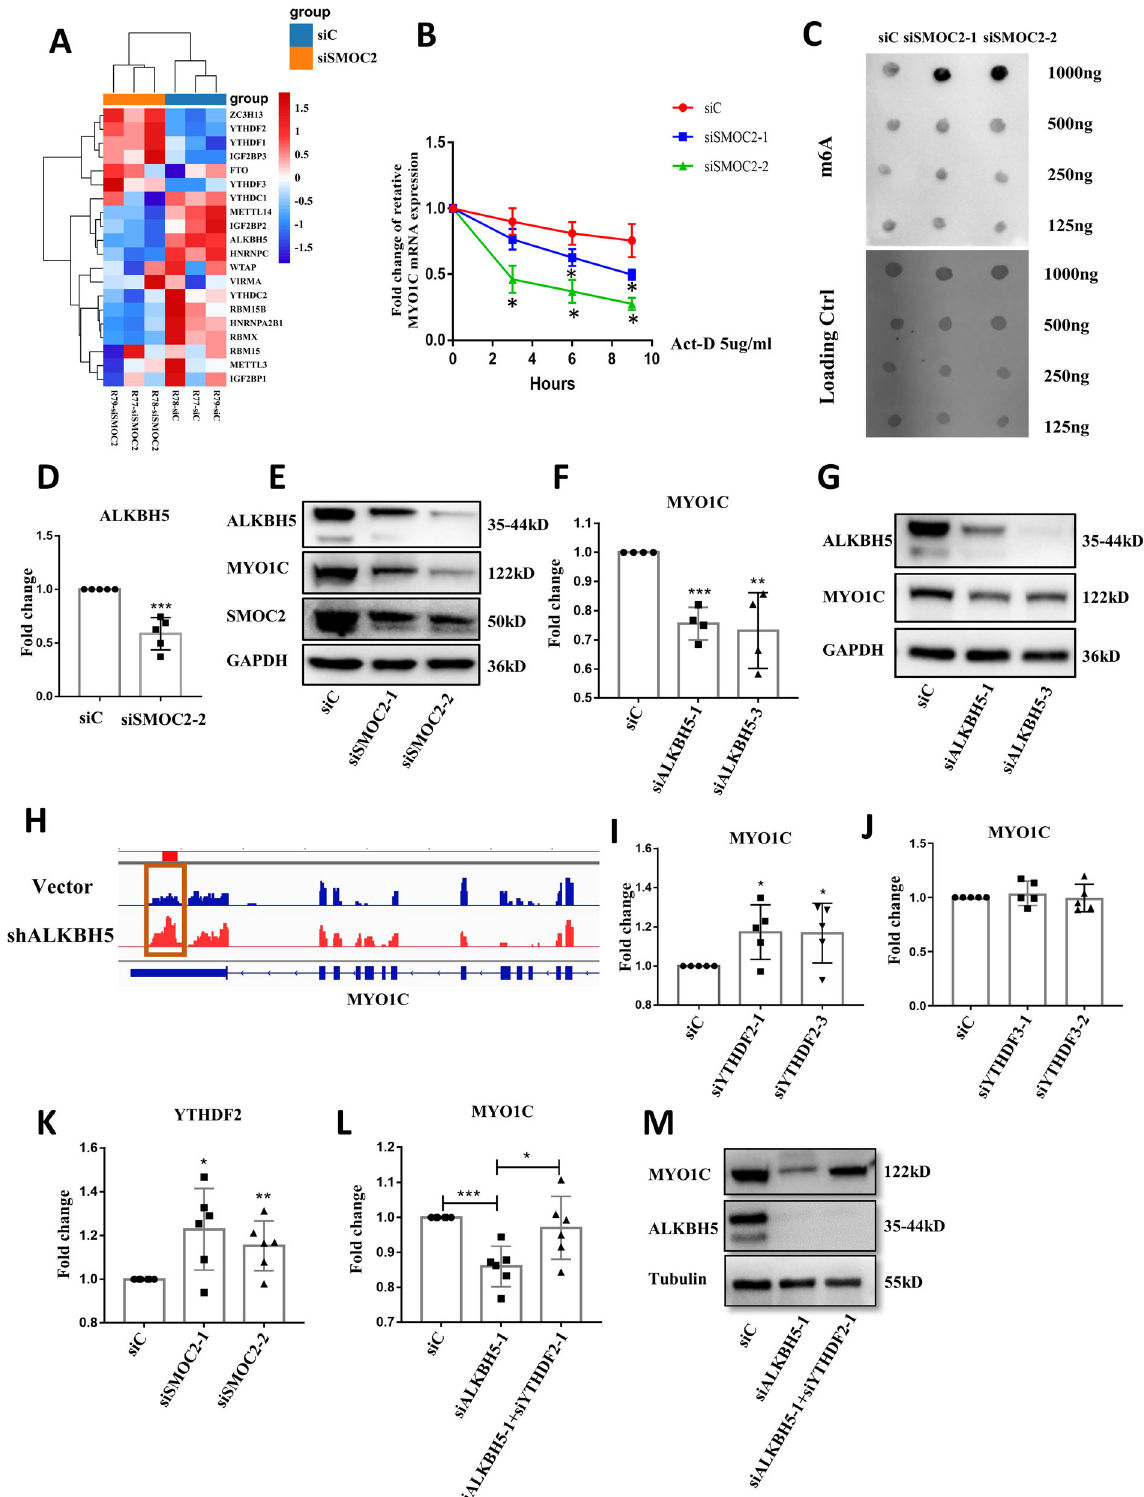
(micro-CT) (Fig. 7F, G). We further validated the reduction of SMOC2, MYO1C, ALKBH5 and SOX4 expression in the synovium of rats with CIA with SMOC2 silencing (Fig. 7H, Supplementary Fig. S7A, B). Collectively, our data suggest that SMOC2 inhibition may provide a novel potential target for RA